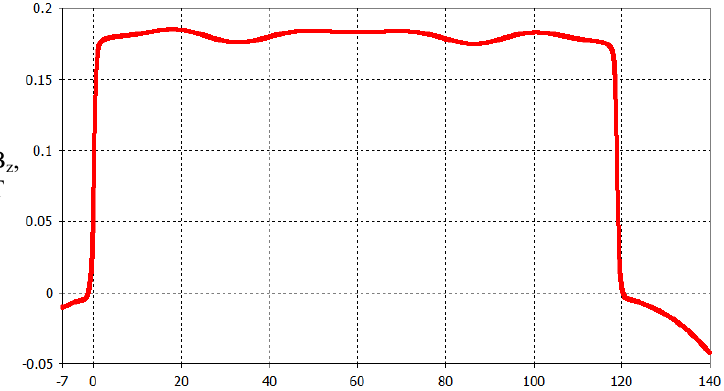
Fig. 4. The distribution of magnetic field on the MFS gap axis in the transit channels.